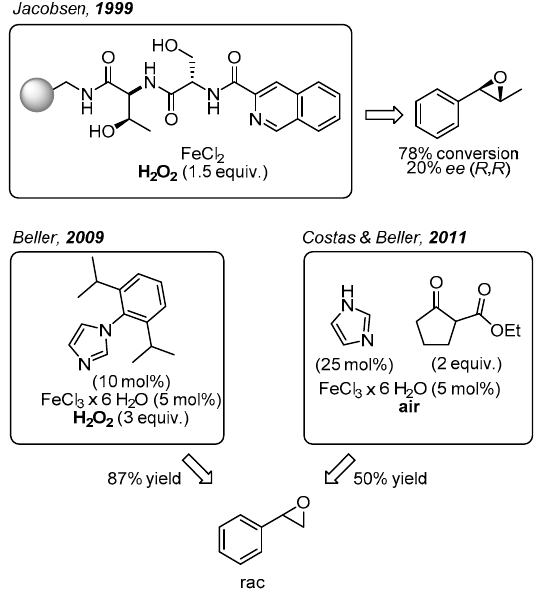
Figure 2. Biomimetic non-heme iron-catalyzed epoxidations reported by Jacobsen [18], Beller [17], Costas and Beller [16].